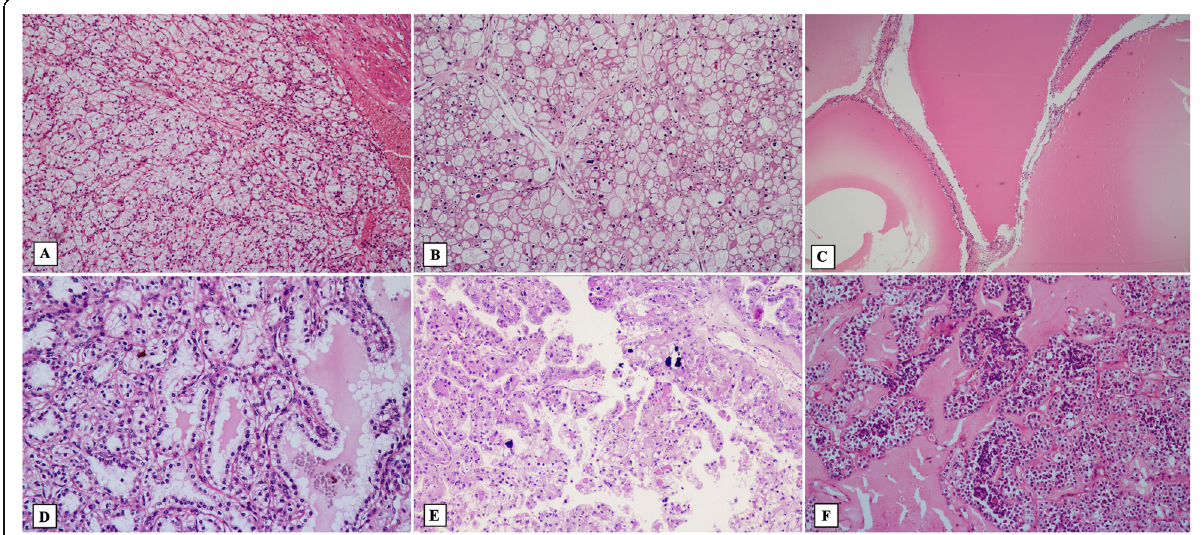
Fig. 1 Renal cell carcinomas with “ clear cells ” . (Conventional) Clear cell carcinoma showing typical low-grade areas with nests, acini and cords of clear cells intermixed with a delicate network of capillary vessels ( a HE, 100x). Chromophobe carcinoma typically shows sheets of cells separated by incomplete septations. Large eosinophilic cells (oncocytoma-like) commonly coexist with vegetal-like cells (with distinct cytoplasmic membrane). Typical morphology includes wrinkled ( “ rasinoid ” ) nuclei and perinuclear halos ( b HE, 100x). Multilocular cystic renal neoplasm of low malignant potential shows cystic spaces with delicate septae lined by low-grade clear cells. No expansive growth are observed within septae (